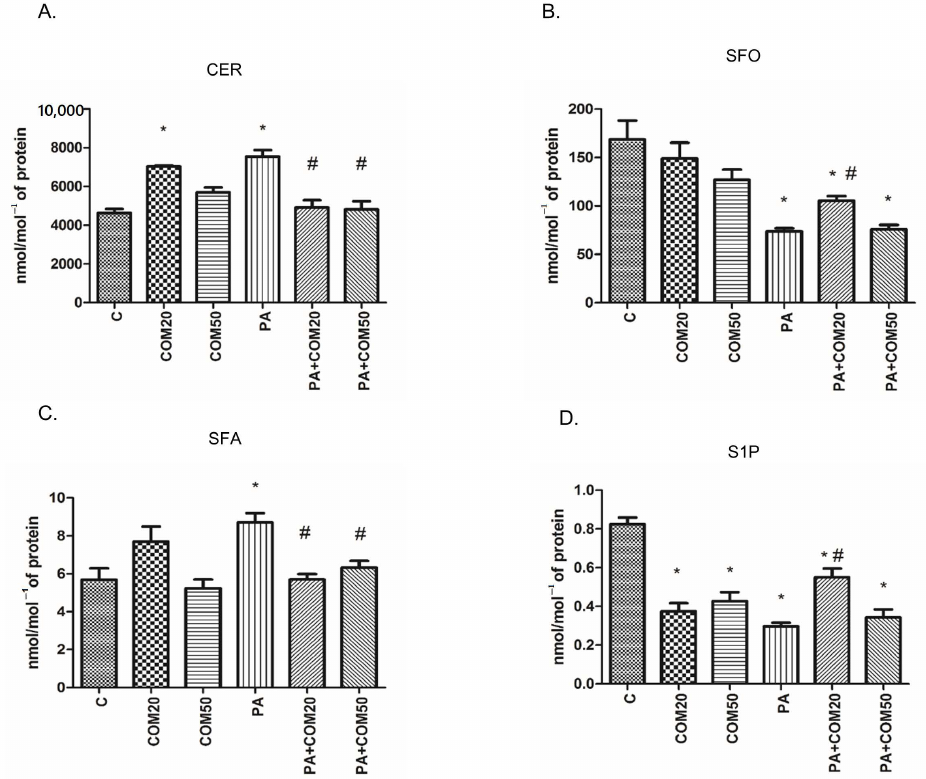
Figure 1. The concentrations of CER—ceramide ( A ), SFO—sphingosine ( B ), SFA—sphinganine ( C ), and S1P—sphingosine-1-phosphate ( D ) in primary rat hepatocytes. The cells were incubated with the presence or absence of PA (0.5 mM) or/and COM (20 or 50 µ M), as it was described in Materials and Methods section. The concentrations of sphingolipids were measured by HPLC technique. The data are shown as the mean ± SD and are based on six independent determinations ( n = 6); * p < 0.05 significant difference vs. control group; # p < 0.05 significant difference vs. palmitate group; C, control; COM20 or COM50, coumestrol 20 or 50 µ M; PA, palmitic acid; PA + COM20 or PA + COM50, palmitic acid + coumestrol 20 or 50 µ